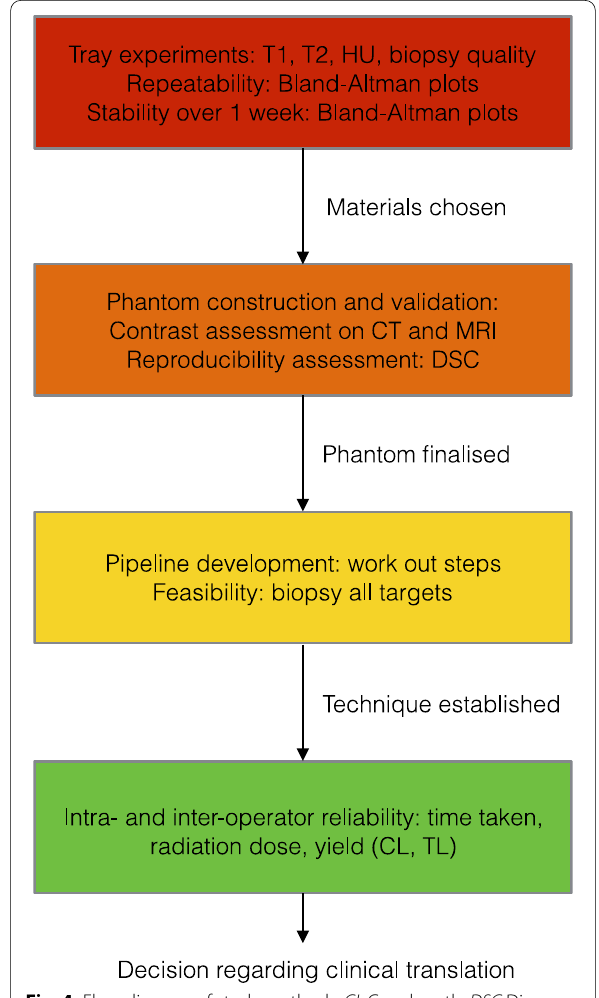
Fig. 4 Flow diagram of study methods. CL Core length, DSC Dice similarity coefficient, HU Hounsfield units, TL Target